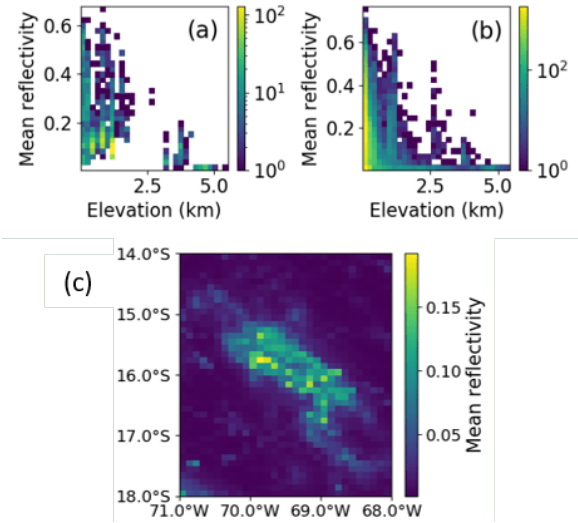
Figure 5. Density plots of CYGNSS reflectivity vs the elevation. (a) Pixels over lakes, (b) pixels over floodplains, and (c) map of CYGNSS mean reflectivity over the Titicaca Lake at 3800 m